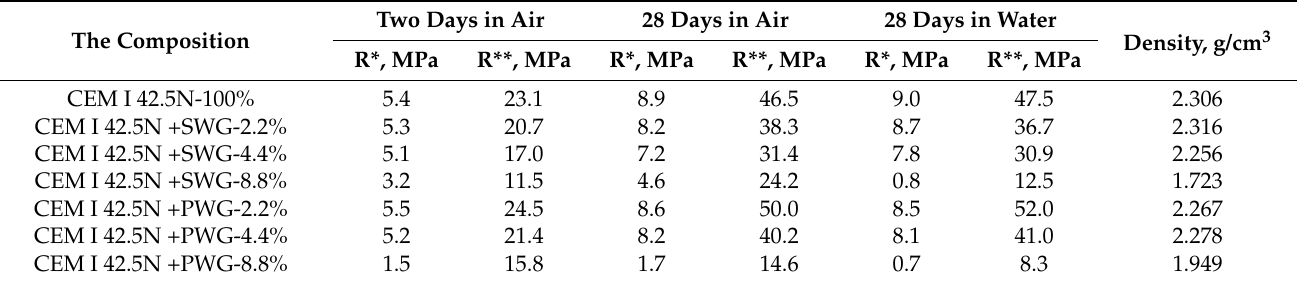
Table 4. Dependence of strength on the exposure time and storage conditions of CEM I 42.5N